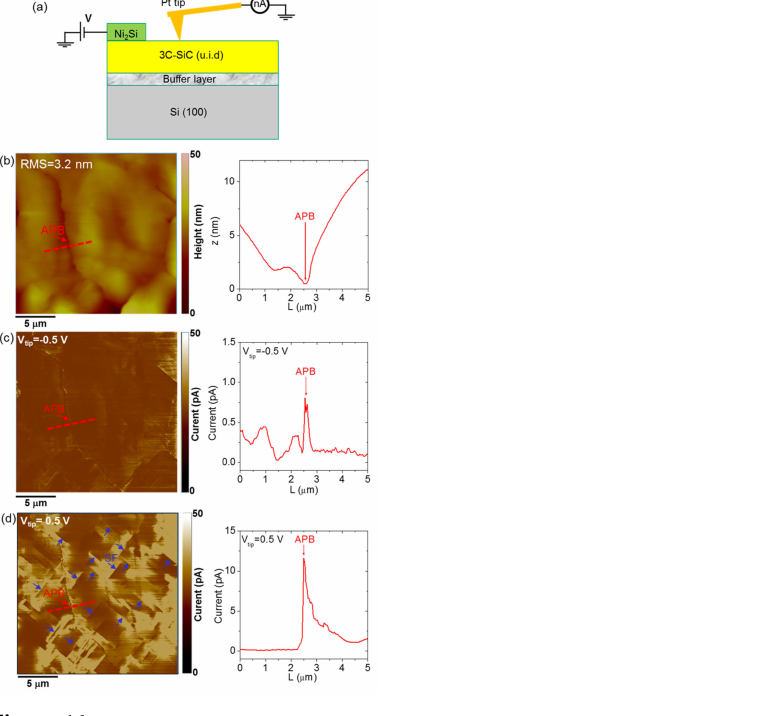
Figure 16. ( a ) Schematic illustration of the CAFM setup. ( b ) Morphology and ( c ) current maps collected under reverse-bias polarization of the tip (Vtip = − 0.5 V) and ( d ) forward-bias polarization (Vtip = 0.5 V). An APB is indicated by a red arrow and SFs by blue arrows. Representative line-scans across a grain boundary extracted from the topography (( b ), right panel), current maps under reverse-bias polarization (( c ), right panel), and forward-bias polarization (( d ), right panel) of the tip are shown (see Reference